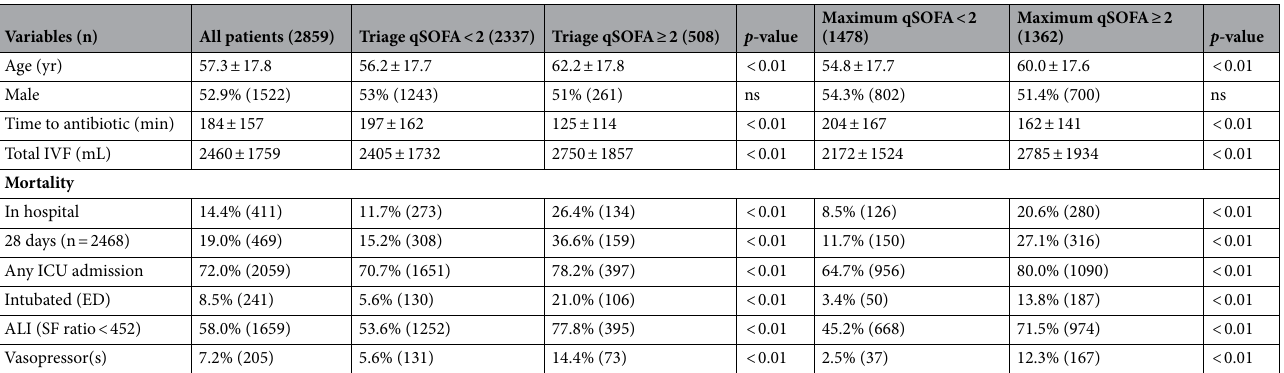
Table 1. Patient Demographics and clinical characteristics stratified by serial qSOFA